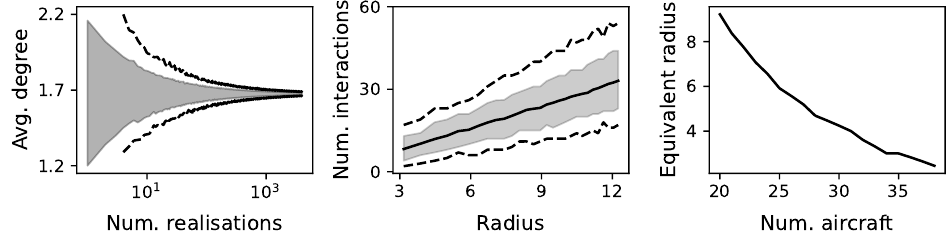
Figure 2. Basic analysis of the synthetic model. ( Left ) Distribution of the obtained average degree as a function of the number of realizations. The gray band and the black dashed lines, respectively, represent the 10–90 and the 1–99 percentiles. ( Center ) Evolution of the number of interactions as a function of the radius ρ , for N = 20 aircraft. The black solid line reports the average, while the gray band and the dashed black lines, respectively, represent the 10–90 and the 1–99 percentiles. ( Right ) Evolution of the equivalent radius ρ e needed to recover the same number of interactions, as obtained for N = 20 and ρ = 10, as a function of the number of simulated